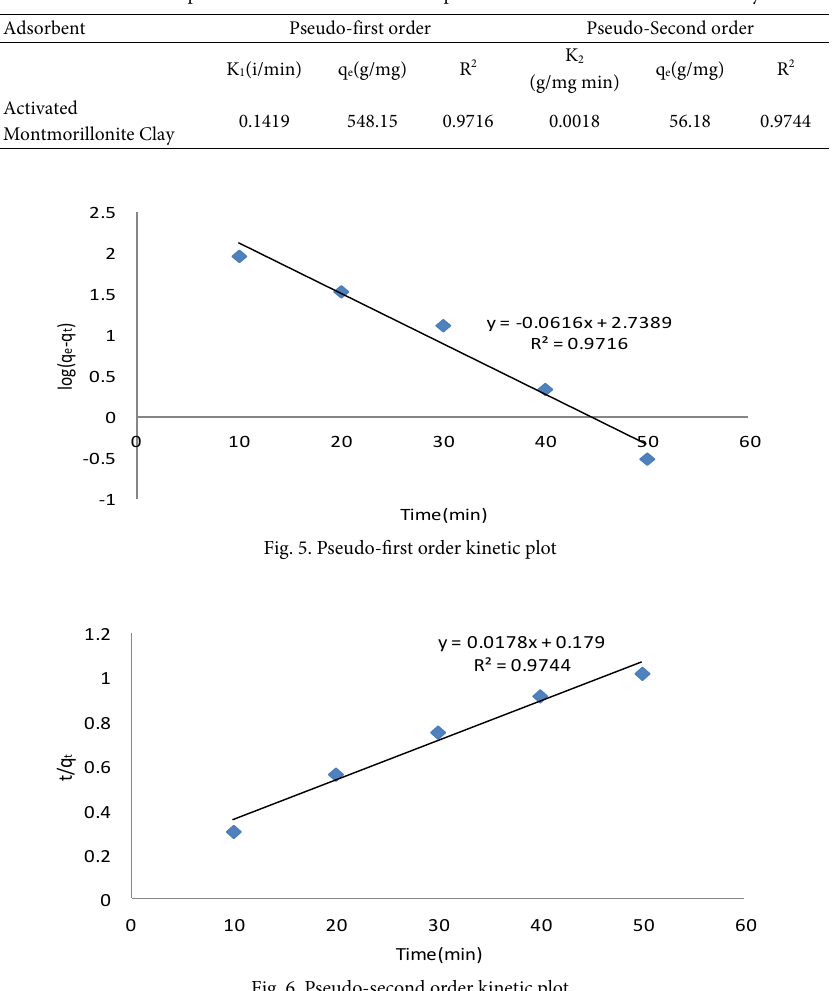
Fig. 5 Pseudo-second order kinetic plot